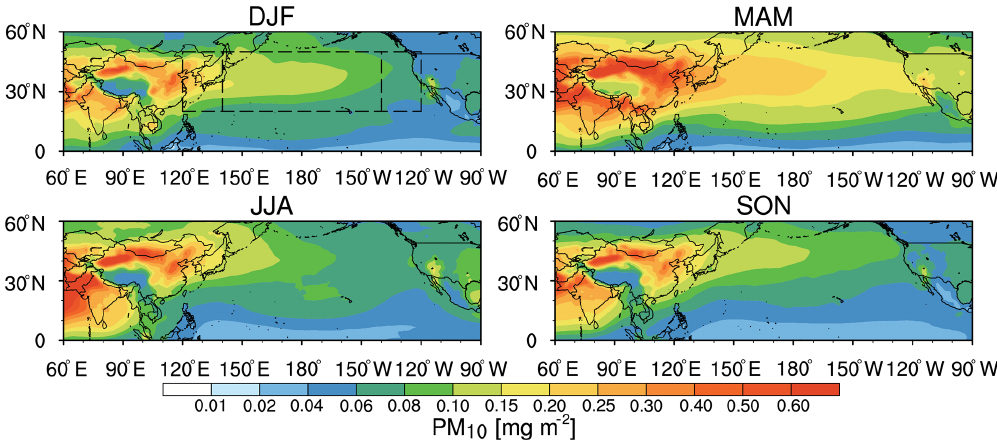
Figure 1. Spatial distribution of seasonal mean aerosol column mass loading from WRF-Chem averaged for 2010–2014. Three regions are denoted by the black boxes: the western Pacific (20–50 ◦ N and 120–140 ◦ E), the central Pacific (20–50 ◦ N and 140 ◦ E–140 ◦ W), and the eastern Pacific (20–50 ◦ N and 140–120 ◦ W) for analysis. PM 10 is including the mineral dust, sulfate (SO 4 ), nitrate (NO 3 ), ammonium